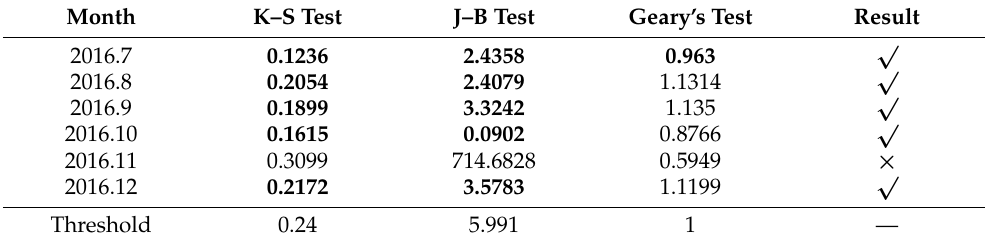
Table 3. Result of normality test.